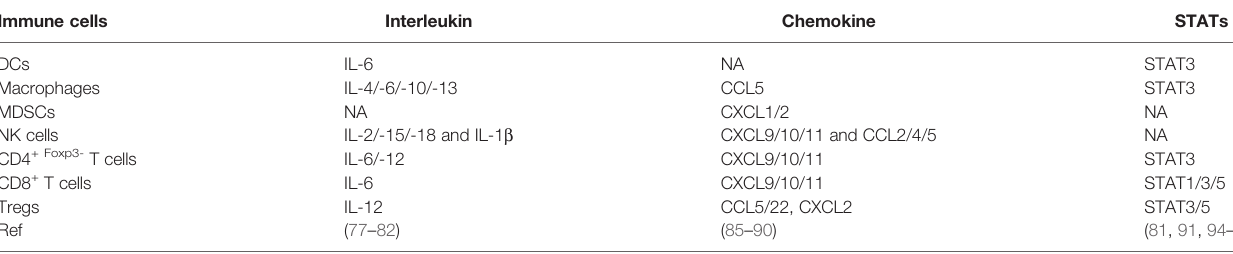
TABLE 3 | Cytokines and STATs involved in regulating immune cells of